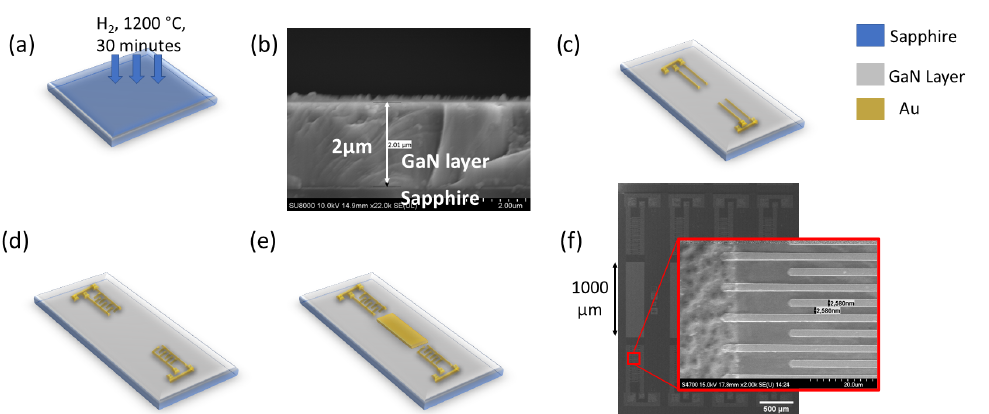
Figure 2. Thermal cleaning of the sapphire substrate by using gaseous H2 at 1200 °C for 30 min ( a ), cross-section of GaN growth on top of sapphire with an AlN buffer ( b ), coplanar wavepad deposited on top of the GaN layer ( c ), variation in IDTs: 2.5 µm-, 5 µm-, and 7.5 µm-width are deposited ( d , e ), a thin film of Au/Ti (200 nm/20 nm) is deposited, which acts as a guiding layer, ( f ) final SEM structure of the SAW